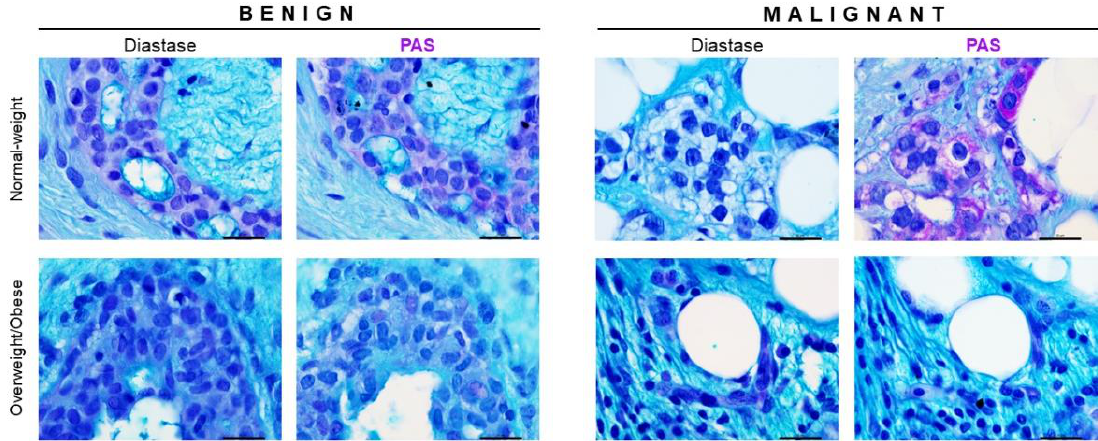
Figure 3. Glycogen content changes in breast cancer tissue are associated with obesity. Periodic Acid-Schiff (PAS) staining and light microscopy showing glycogen localization patterns in benign and malignant tumor tissues. Glycogen (purple staining) localization in breast cancer cells in malignant tumor tissue and breast epithelial cells in benign tumor tissue of normal-weight and overweight/obese premenopausal women. For each sample, PAS staining is presented next to the serial section pretreated with diastase, an enzyme that catalyzes glycogen hydrolysis. Magnification: ×100, orig. Scale bar: 20 µm.